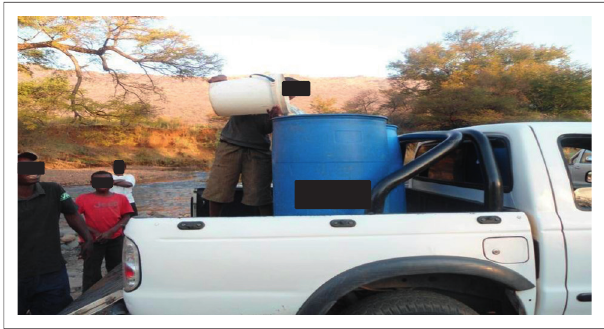
FIGURE 4: People fetching water from Tubatse River.